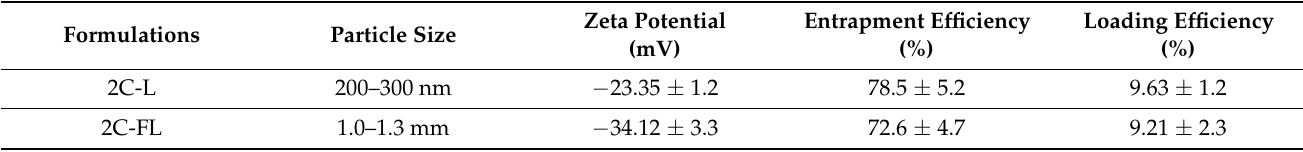
Figure 1. Physical properties of 2C-FL (2C-encapsulated fibrin liposomes) formulations. ( A ) Trans- mission electron microscopic image of 2C-L nanoparticles. ( B ) Representative optical image of 2C-FL formulations. Table 1. Characteristics of 2C-encapsulated